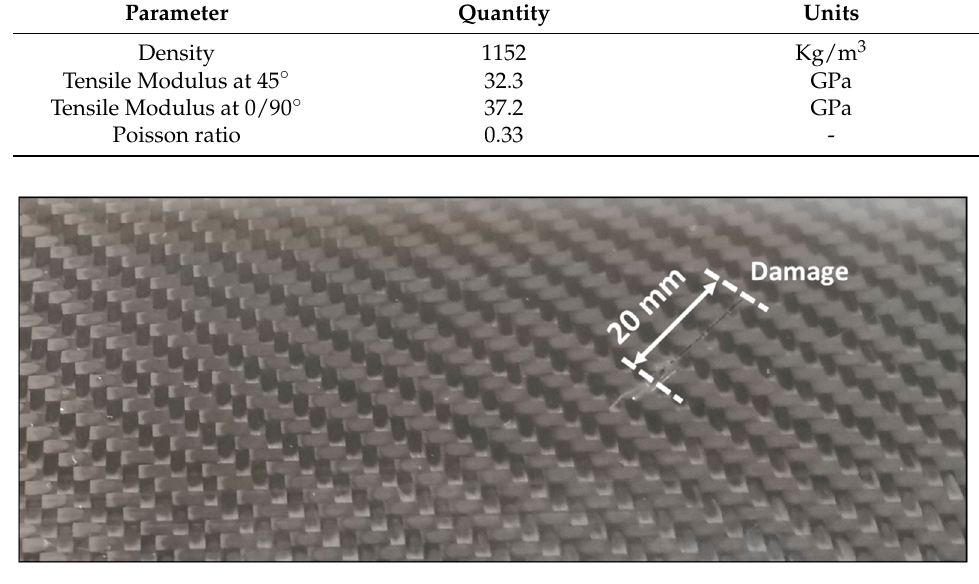
Figure 1. Photograph of a portion of the CFRP specimen containing the artificial damage.